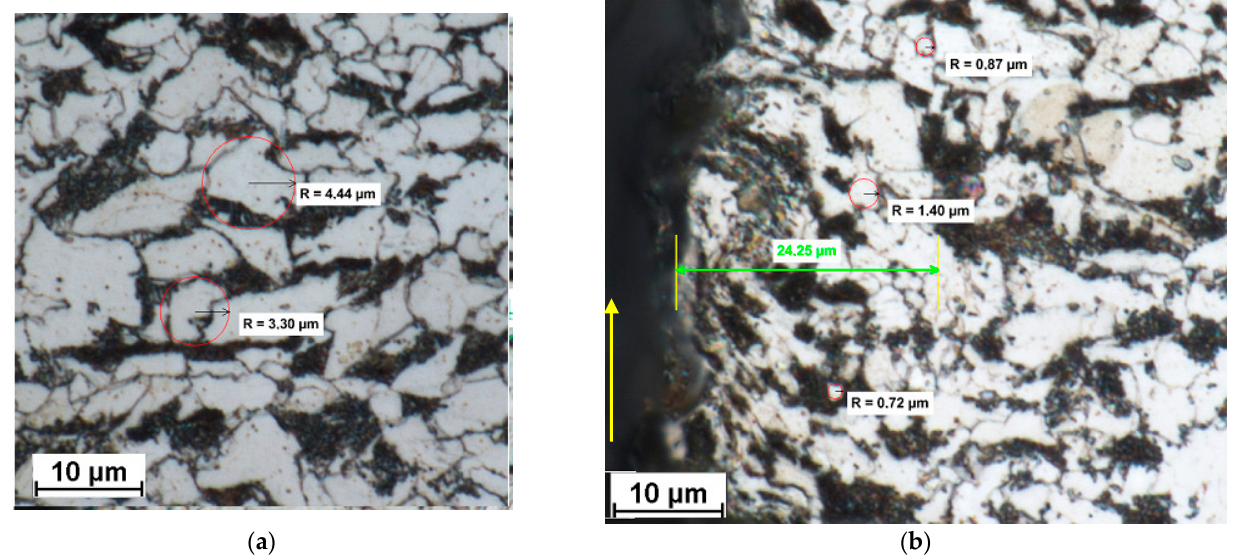
Figure 10. Metallographic microstructure of the cross-sectional area of cut produced at an medium power density of the jet ( a ) at a depth of about 3 mm from the upper cutting edge, ( b ) the cutting edge (a pressure of 340 MPa and a cutting speed of 300 mm/min).